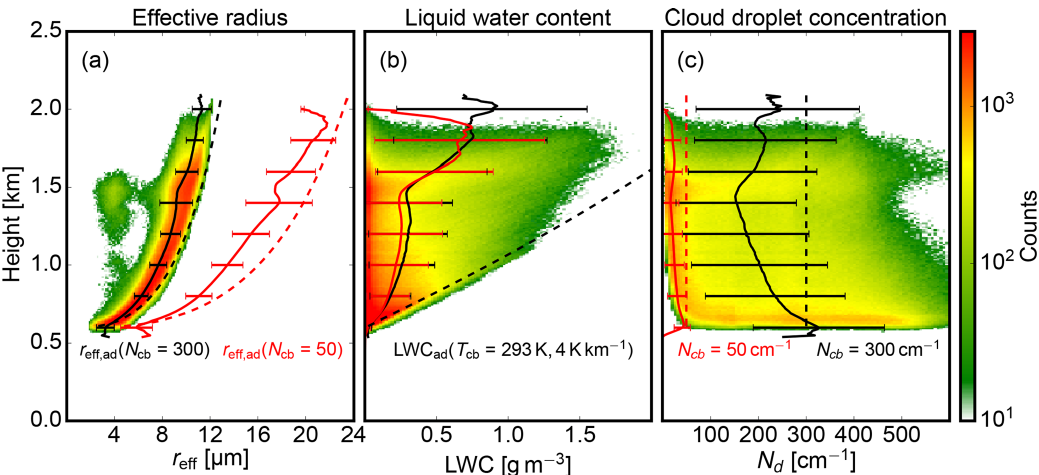
Figure 3. The contoured frequency of altitude diagrams (CFADs) shows the (a) effective radius r eff , (b) liquid water content LWC, and (c) cloud droplet number concentration N d for the polluted cases with N CCN = 1000cm − 3 . The respective mean profile (black solid line) and its standard deviation (error bar) are superimposed. For the polluted cases with N CCN = 100cm − 3 , only the mean profiles are shown (red solid lines). In both cases, the dashed profile is the theoretical adiabatic limit calculated for conditions at cloud base ( T cb = 293K , 4Kkm − 1 ) and N cb = 300cm − 3 for the polluted and N cb = 50cm − 3 for the clean